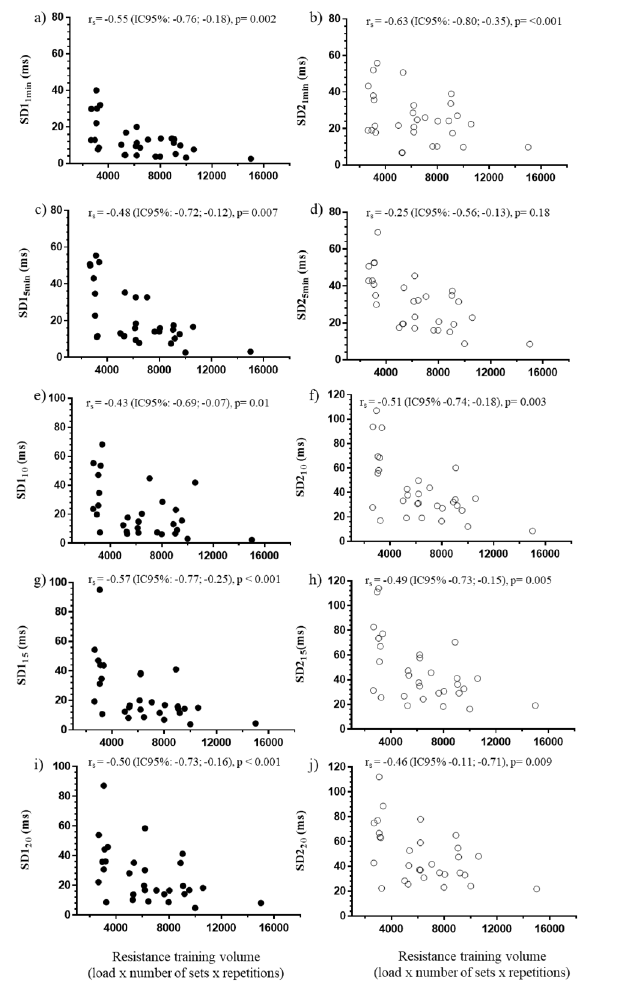
Figure 2- Correlation between resistance exercise volume (load x number of sets x number of repetitions) and cardiac parasympathetic (SD1-closed circle) and global (SD2-open circle) modulation during the 1st (a-b), 5th (c-d) 10th (e-f), 15th (g-h), and 20th minutes of the post-exercise recovery